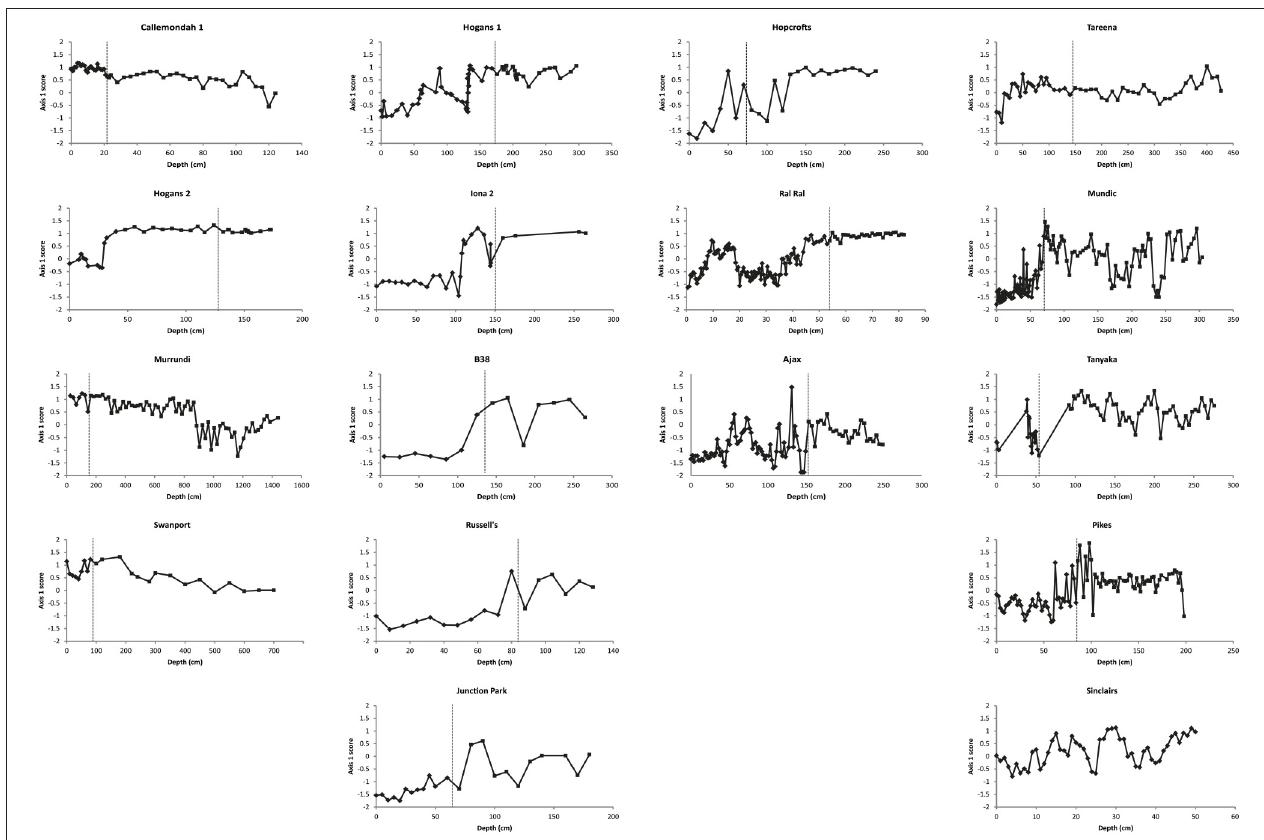
FIGURE 6 | Change in nMDS axis 1 scores over time in stable, switching, and unstable billabongs. Dashed vertical lines indicate inferred timing of European settlement based on the appearance of exotic pollen and/or magnetic susceptibility